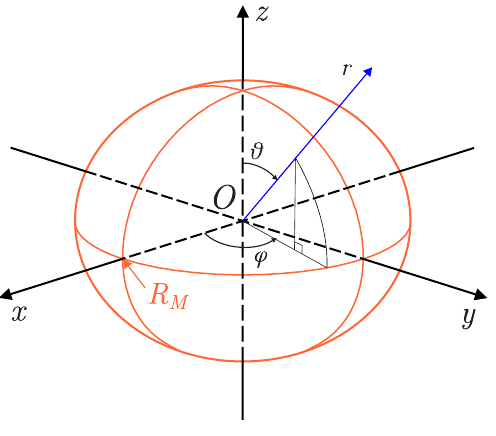
Figure 2. The planetary coordinate system used in solving the